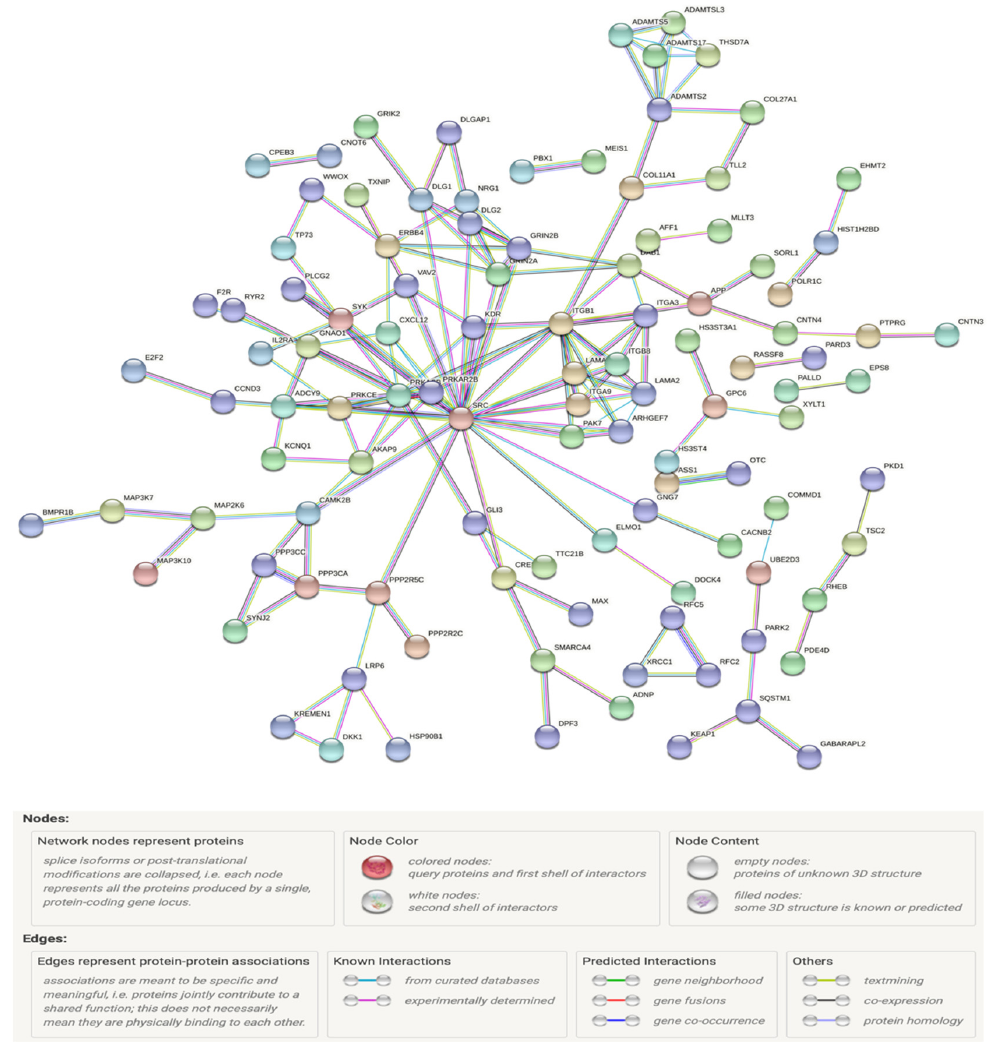
Figure 8. Protein–protein interactome (PPI) generated from regression analyses of significant cg19693031 GxMeth effects against HbA1c . cg19693031 GxMeth effects against